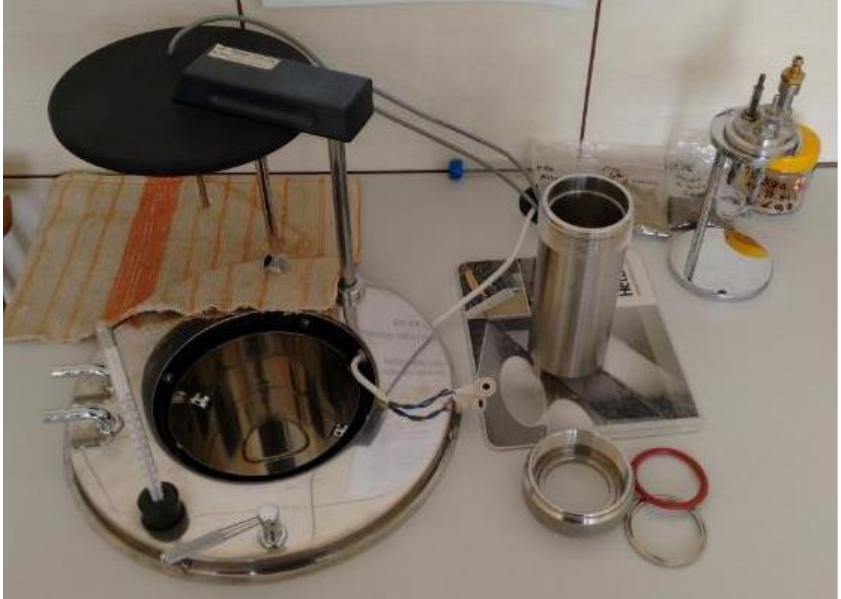
Figure 3. An overall view of the research site for calorimetric measurements ( left ) calorimeter bomb ( right ). [Source: Authors’ original photo].